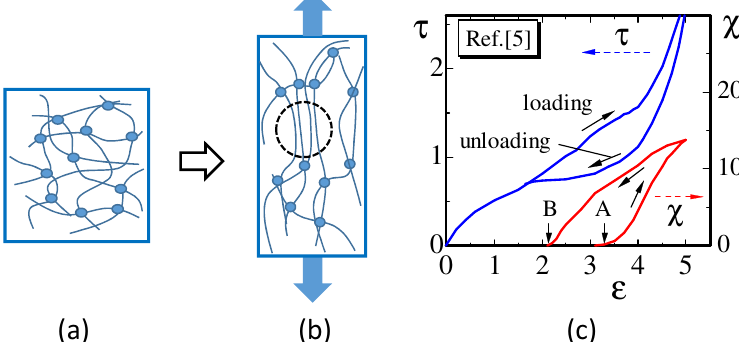
Figure 1. ( a ) The h state of rubber, where the polymer directions are isotropic, ( b ) extended or elongated state of rubber, where the polymer directions align along the tensile force direction and strain-induced crystallization (SIC) starts to appear, and ( c ) an illustration of stress–strain curves and crystallization ratio χ for loading and unloading processes influenced by SIC. Small circles in ( a , b ) represent cross-linkers. In ( c ), the letter A (B) denotes the point where crystallization starts (terminates) in the loading (unloading) process. The stress τ ( MPa ) and the crystallization ratio χ ( % ) in ( c ) are taken from experimental data in